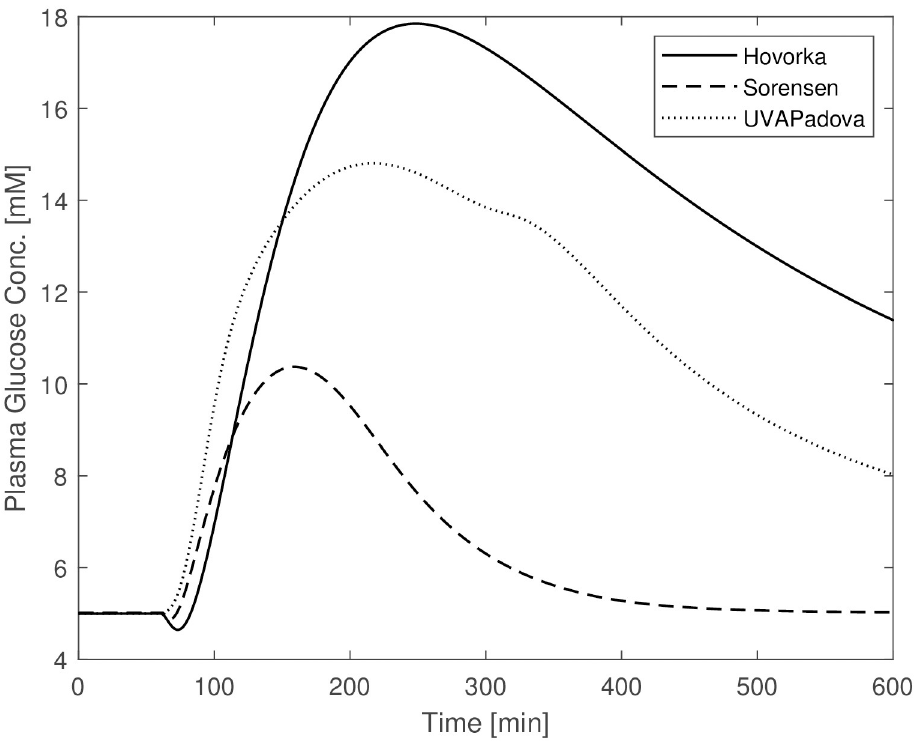
Fig 1. Blood glucose concentrations from Hovorka (solid line), Sorensen (dashed line) and UVAPadova (dotted line) models with the original Sorensen model, during an in-silico OGTT experiment in conjunction with an insulin